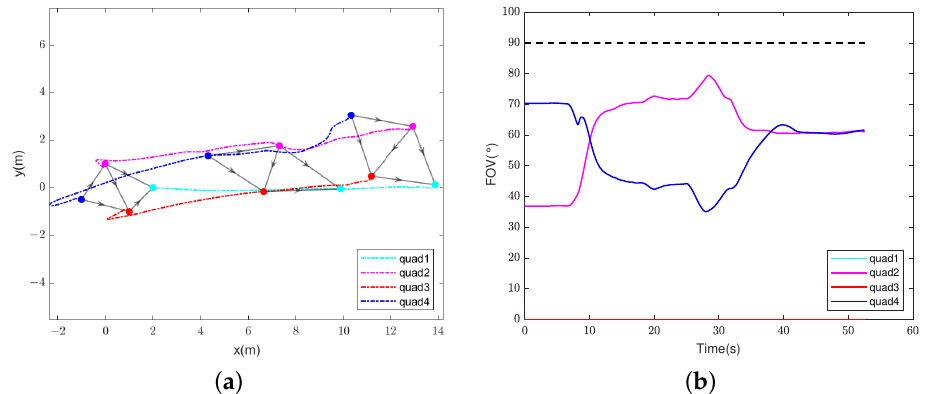
Figure 14. Trajectories and internal angle of four quadrotors. ( a ) Trajectories of four quadrotors. ( b ) Internal angle of four quadrotors formed by the neighbors with upper bound indicated FOV con- straints.